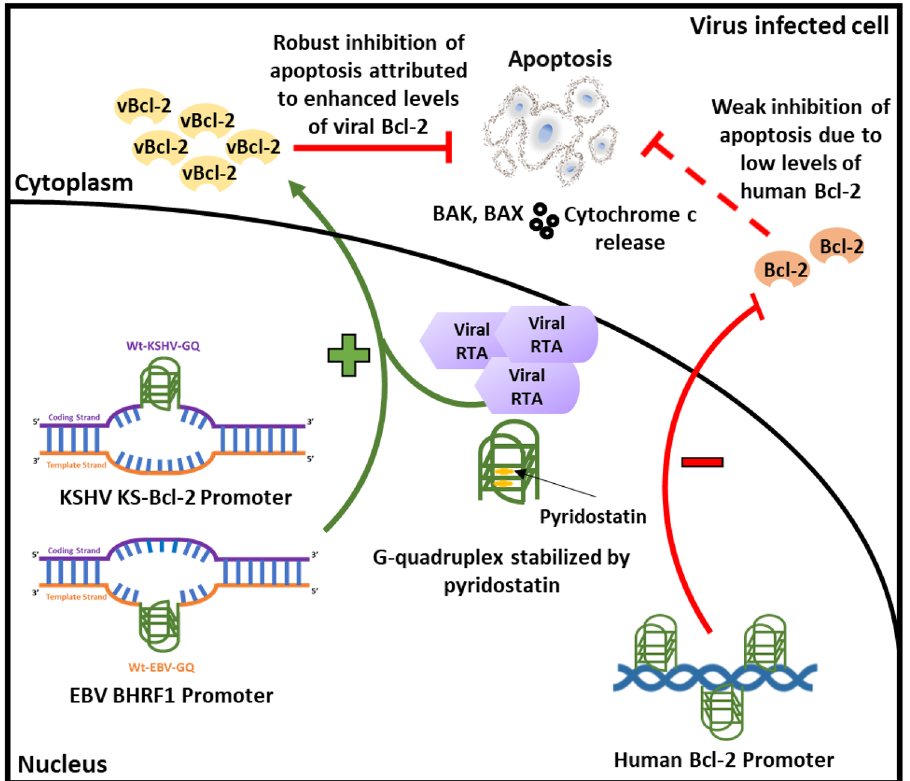
Figure 7. G-quadruplex-mediated regulation of viral and human Bcl-2 expression and its potential effect on host cell apoptosis. The G-quadruplexes in human Bcl-2 promoters inhibit gene expression; this may promote apoptosis of the host cell. The G-quadruplexes in viral Bcl-2 (vBcl-2) promoters serve to enhance vBcl-2 expression. Further, the G-q uadruplexes in vBcl-2 promoters contribute to RTA mediated enhancement of promoter activity. Thus, G-quadruplexes in vBcl-2 promoters enhance vBcl-2 expression which can potentially inhibit host cell apoptosis and thereby confer survival advantage to the